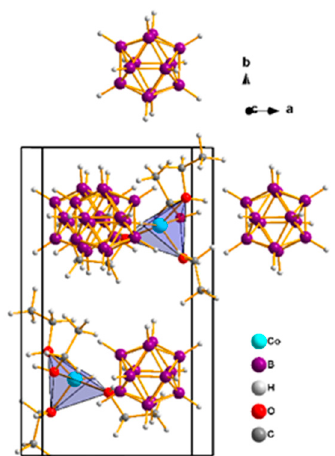
Figure 7. View of the Co coordination square pyramid inside a triangular bipyramid (B 12 H 12 ) 5 of a close to hcp anion packing in m -Co(EtOH) 4 (B 12 H 12 ) as optimized by DFT.